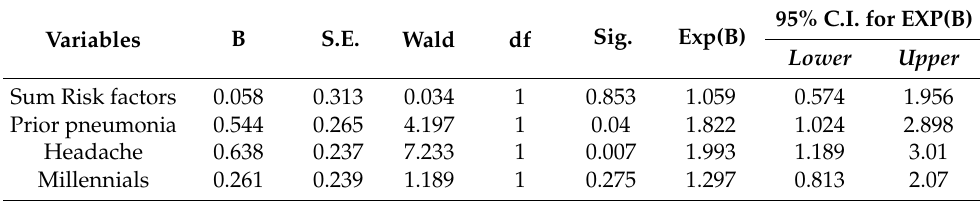
Table 5. Binary logistic regression analysis with a self-reported COVID-19 identified infection as a dependent